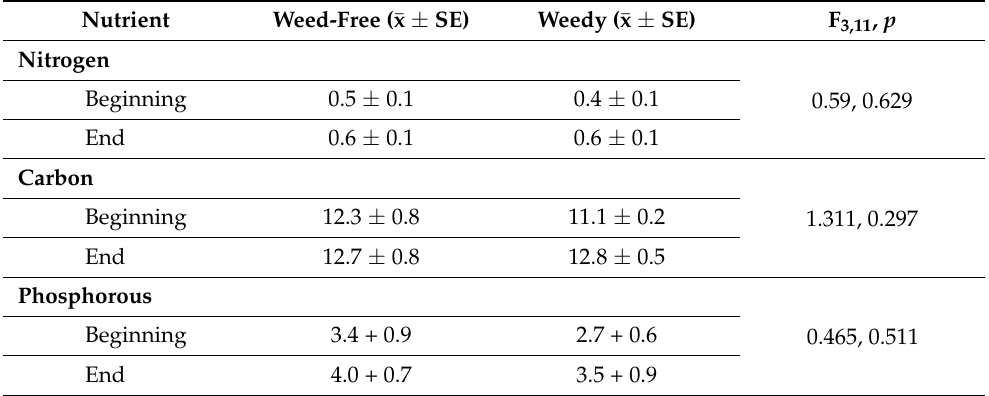
Table A1. Mean levels ( ± SE) of soil nitrogen (%), carbon (%), and phosphorous (mg g − 1 dry weight), weedy or weed-free trees, ANOVA. N = 12 trees: 6 weedy, 6